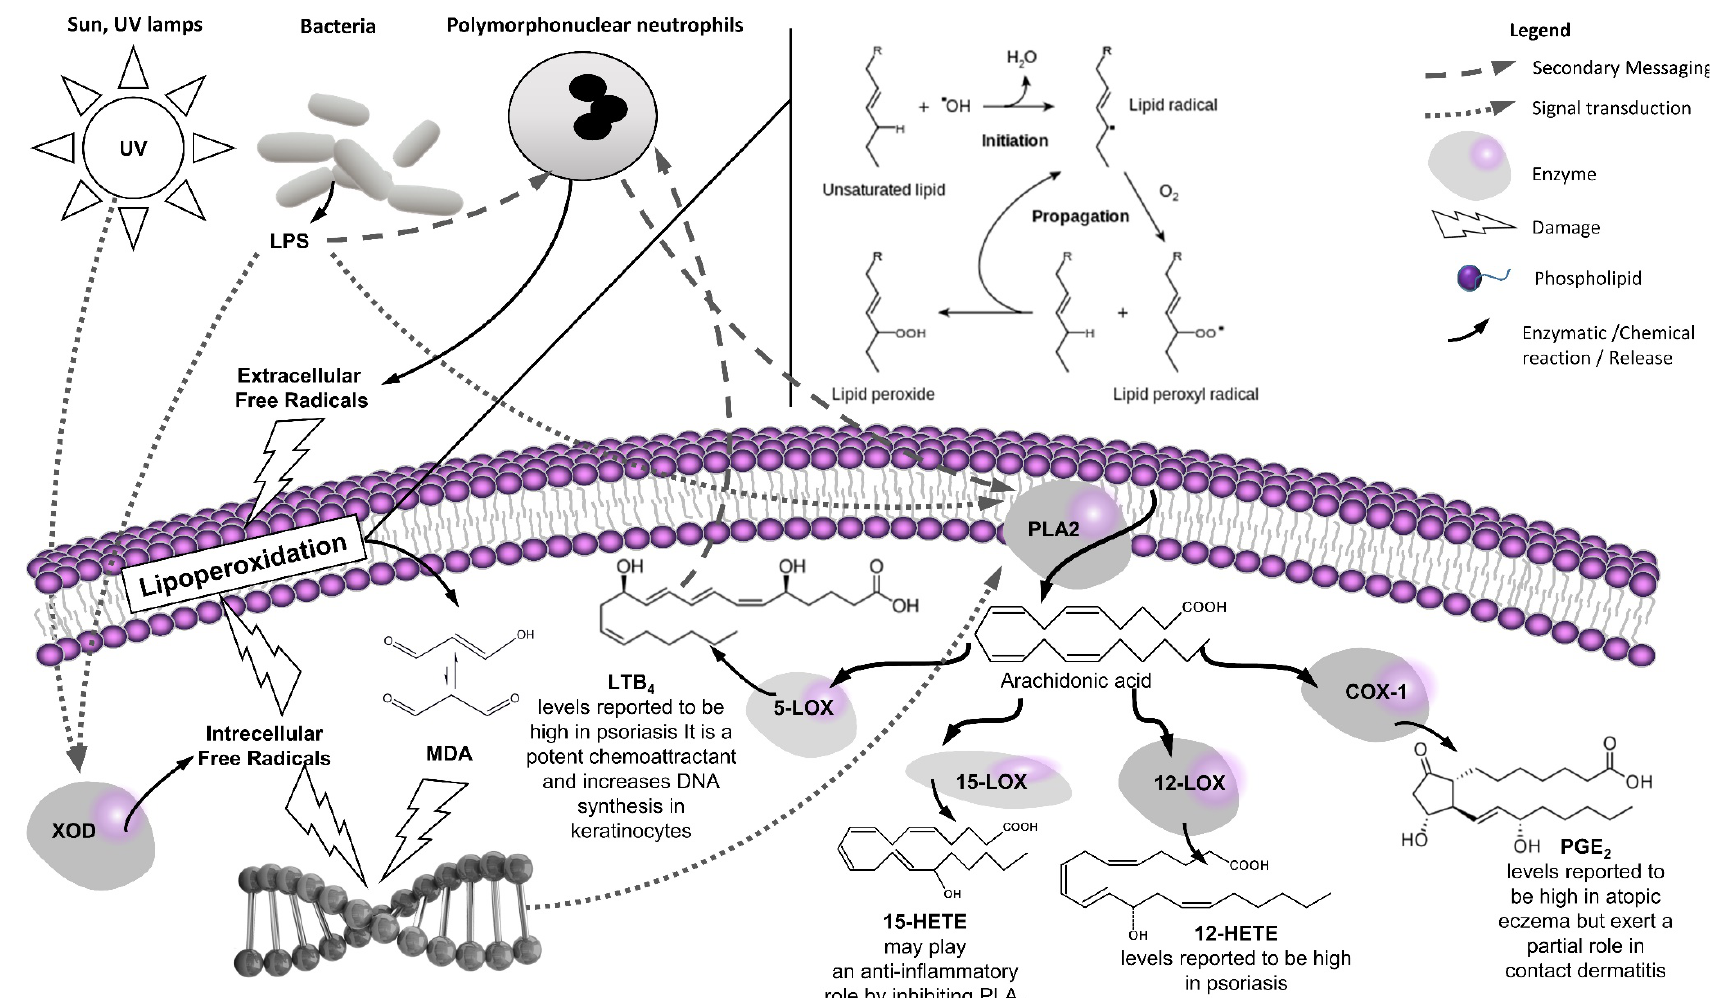
Figure 1. Relationship between lipoperoxidation and skin inflammatory conditions.